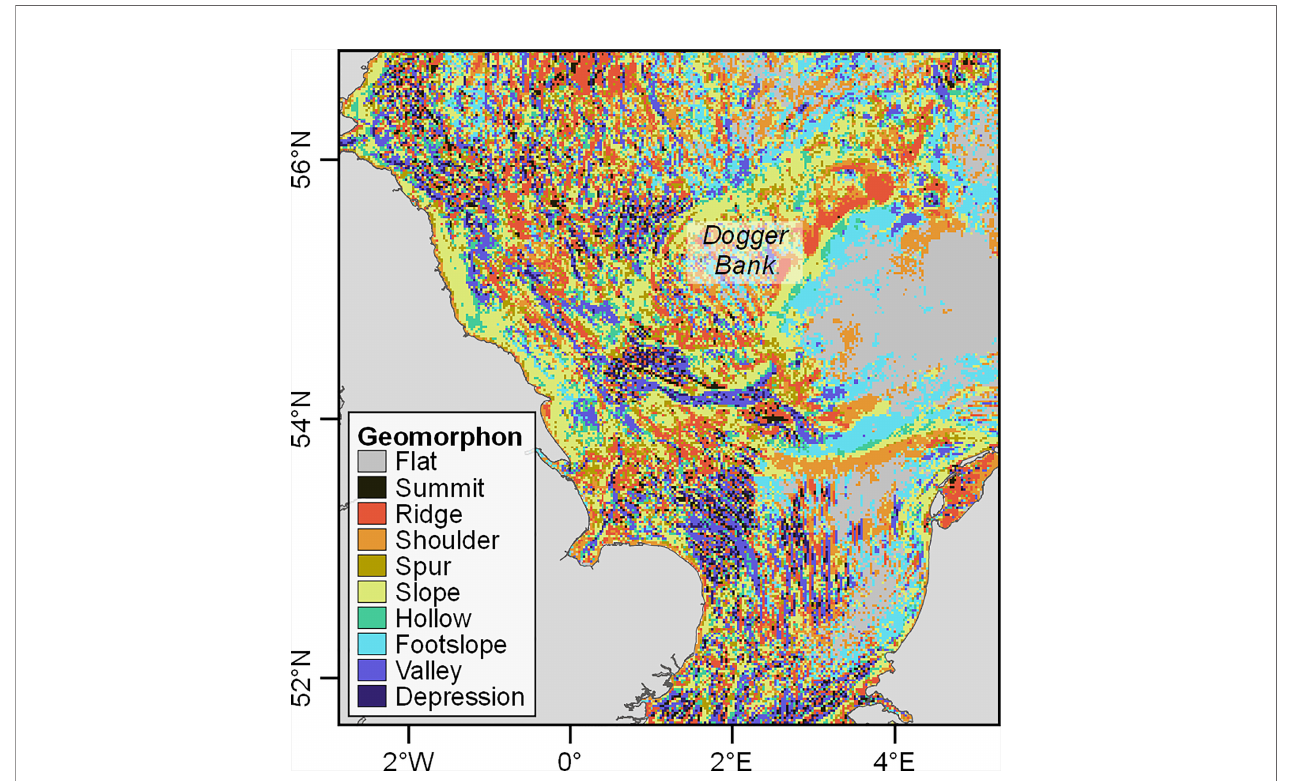
FIGURE 3 | The geomorphology raster of the southern North Sea showing the distribution of the different